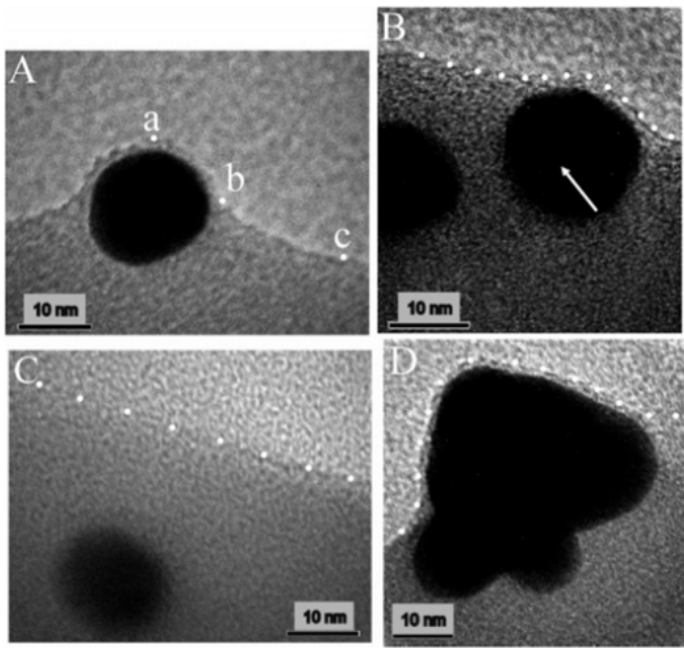
Figure 17. TEM images of gold NP embedding into a polymer melt PS surface upon annealing for three days at 130 °C. Images show ( a ) a partially embedded NP covered by a wetting layer of polymer, ( b ) a nearly completely embedded NP near the surface (indicated by the arrow), ( c ) a completely embedded NP diffused below the surface, and ( d ) a partially embedded cluster containing six to eight NPs and covered by a wetting layer. The dotted lines in b, c, and d are a guide to the eye to denote the polymer surface. (Reproduced with permission from [64], Copyright American Chemical Society 2007).